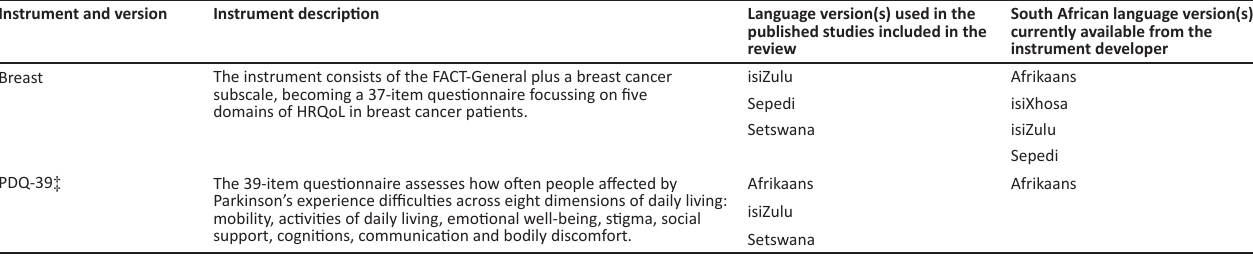
TABLE 2 (Continues...): Translated health-related quality of life instruments that have been used in South Africa. Instrument and version